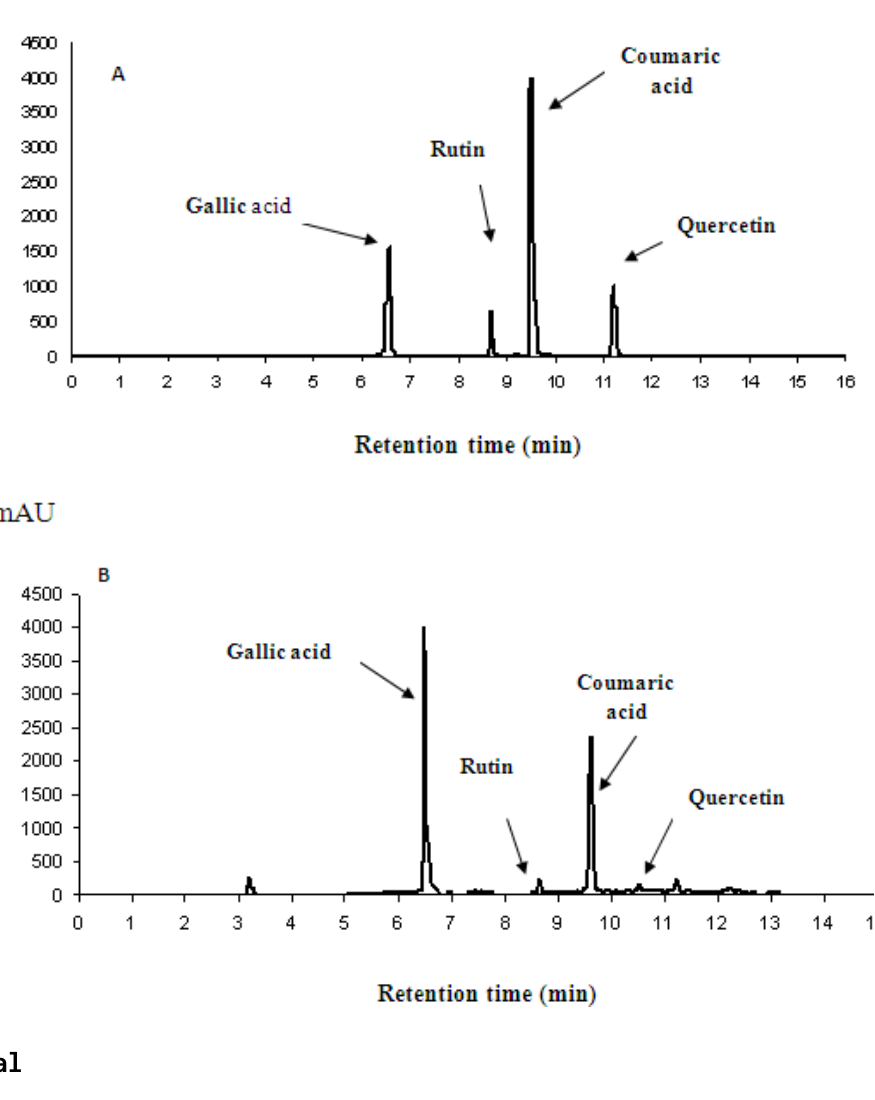
Figure 8. ( A ) HPLC chromatogram of the standards: gallic acid (6.43 min), rutin (8.60 min), coumaric acid (9.43 min) and quercetin (11.13 min) and ( B ) F2 with the same retention times as the standard